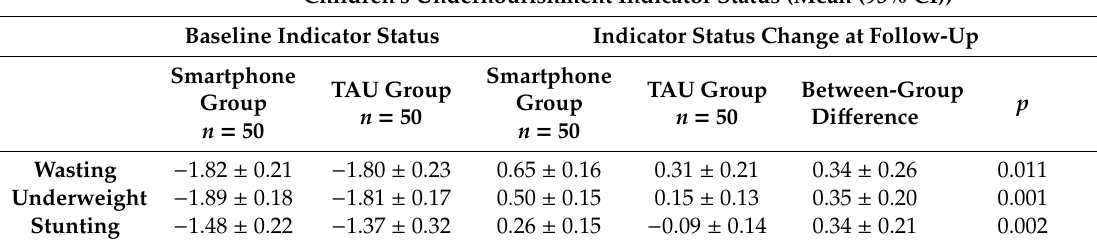
Table 4. Children’s undernourishment indicator status at baseline with regard to wasting (WHZ), underweight (WAZ), and stunting (HAZ), and status changes at follow-up in the smartphone and TAU groups (mean (95% Confidence Interval (95% CI)). P -values indicate di ff erence in status change between the study